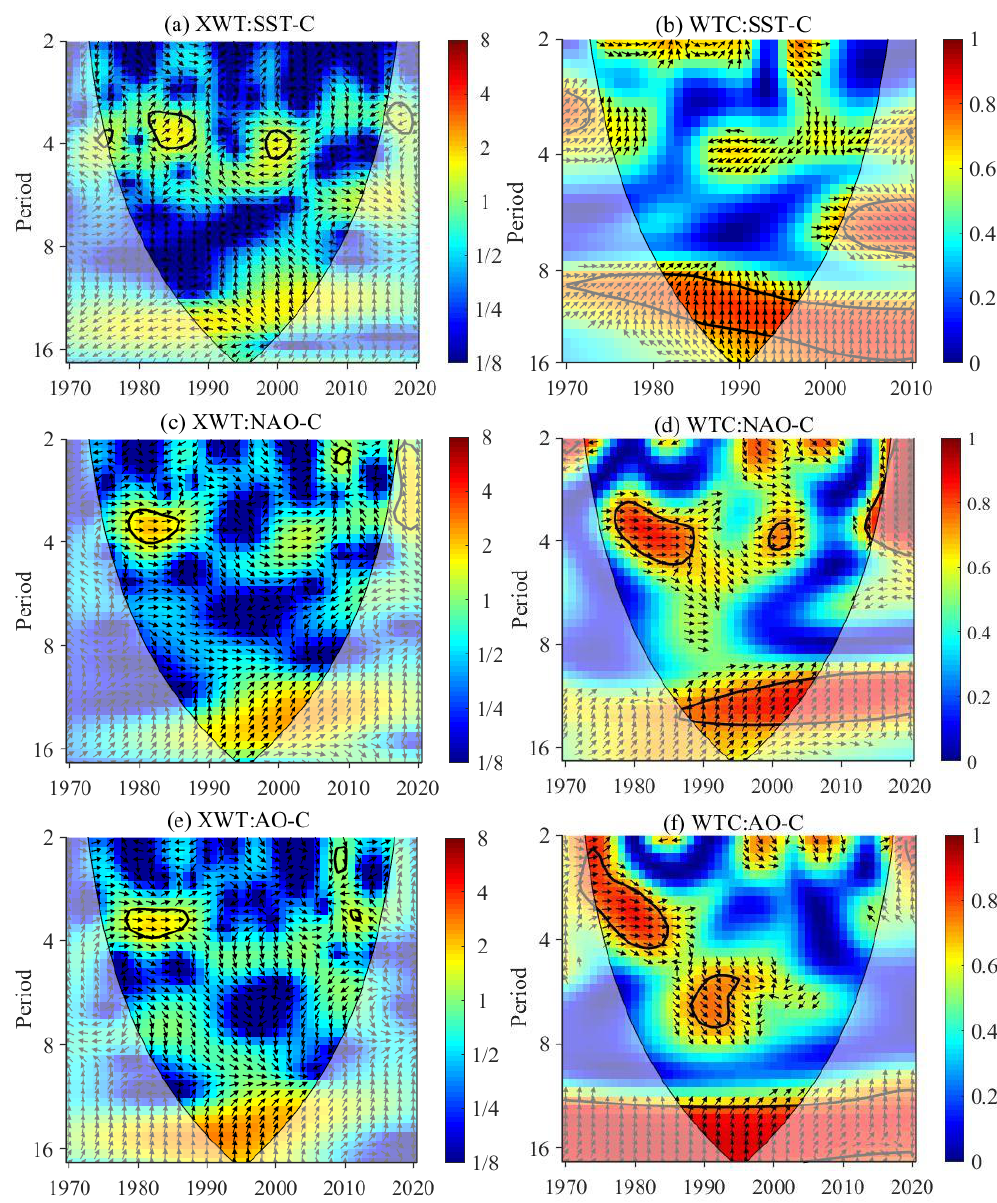
Figure 4. The cross-wavelet power ( a ) and the wavelet coherency ( b ) between the Niño-Southern Oscillation (ENSO) and C-factor value; the cross-wavelet power ( c ) and the wavelet coherency ( d ) between the North Atlantic Oscillation (NAO) and C-factor value; the cross-wavelet power ( e ) and the wavelet coherency ( f ) between the Arctic Oscillation (AO) and C-factor value. Contours are for variance units. The vectors indicate the phase difference between the multivariate climatic index and C-factor value. In all panels, the thick black line is the 5% significance level using the red noise model, and the thin black line indicates the cone of influence.